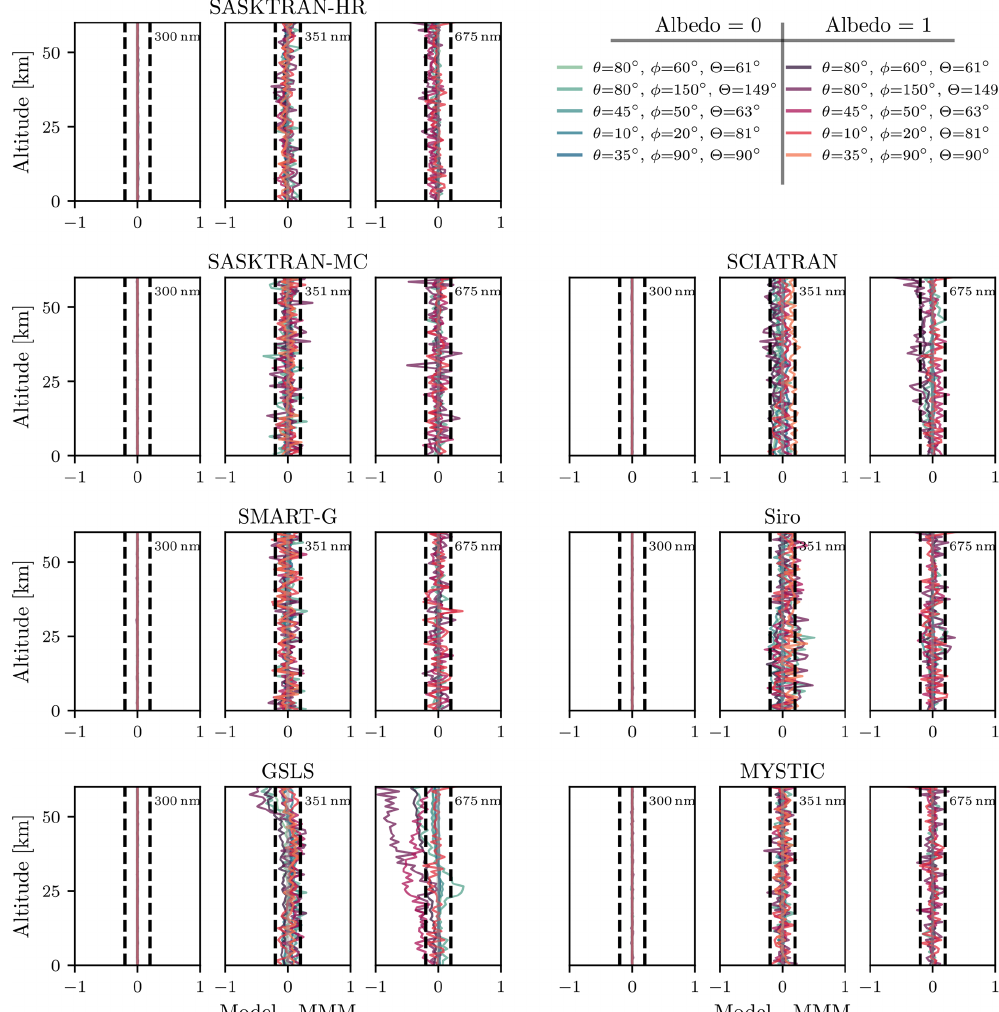
Figure 7. Absolute differences in LPO [ ◦ ] relative to the MMM (MYSTIC, SASKTRAN-MC, and SMART-G) for each RTM at a variety of wavelengths and solar conditions. The atmospheric optical properties include Rayleigh scattering, ozone absorption, and stratospheric aerosol Mie scattering. Refraction is disabled. Dashed vertical lines indicate ± 0 . 2 ◦